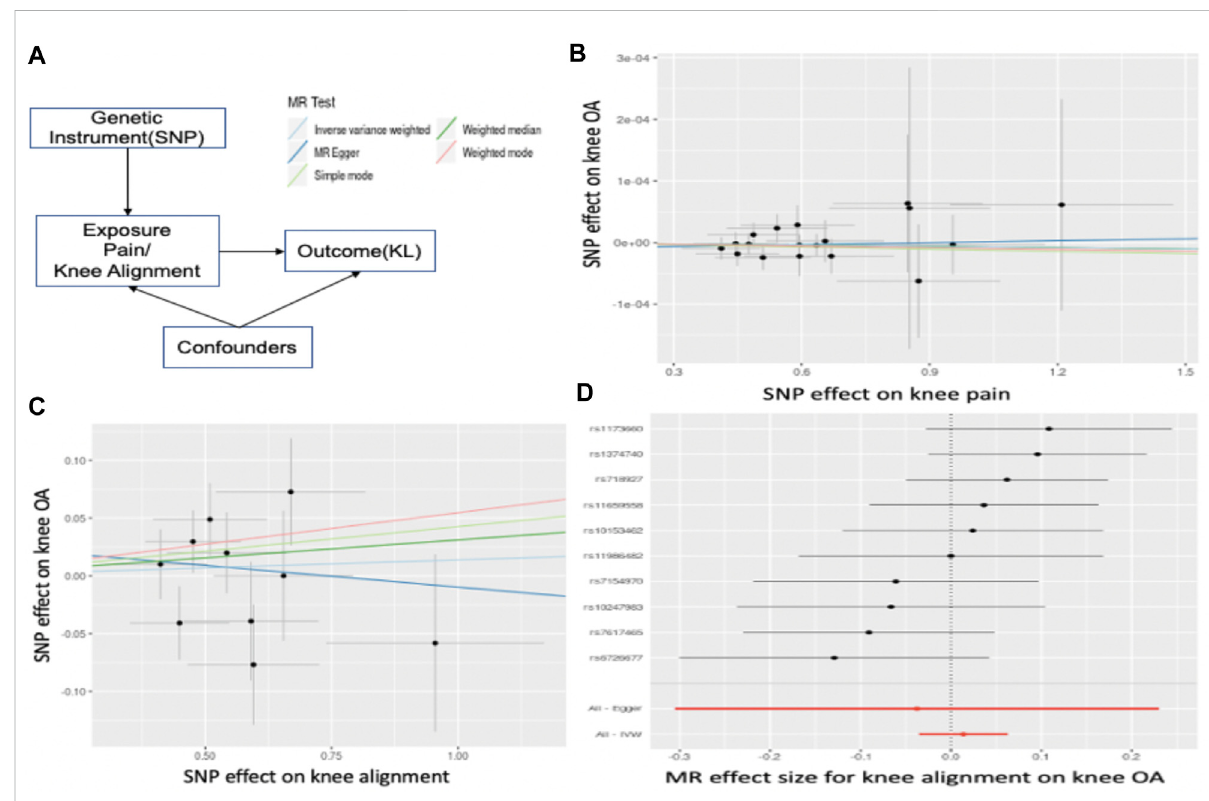
FIGURE 5 Mendelian Randomization. (A) illustrates the estimation of MR. In (B), the x-axis represents the effect of SNPs on pain level and the y-axis is the effect ofSNPs on OA.The slope istheestimatedcausal effect. In (C), thex-axisrepresentstheeffect of SNPs onabnormalknee alignment levels and the y-axis is the effect of SNPs on OA. (D) listed signi fi cant SNPs linking knee alignment level and OA. Each dot represents a SNP, and the line represents the 95% con fi dence